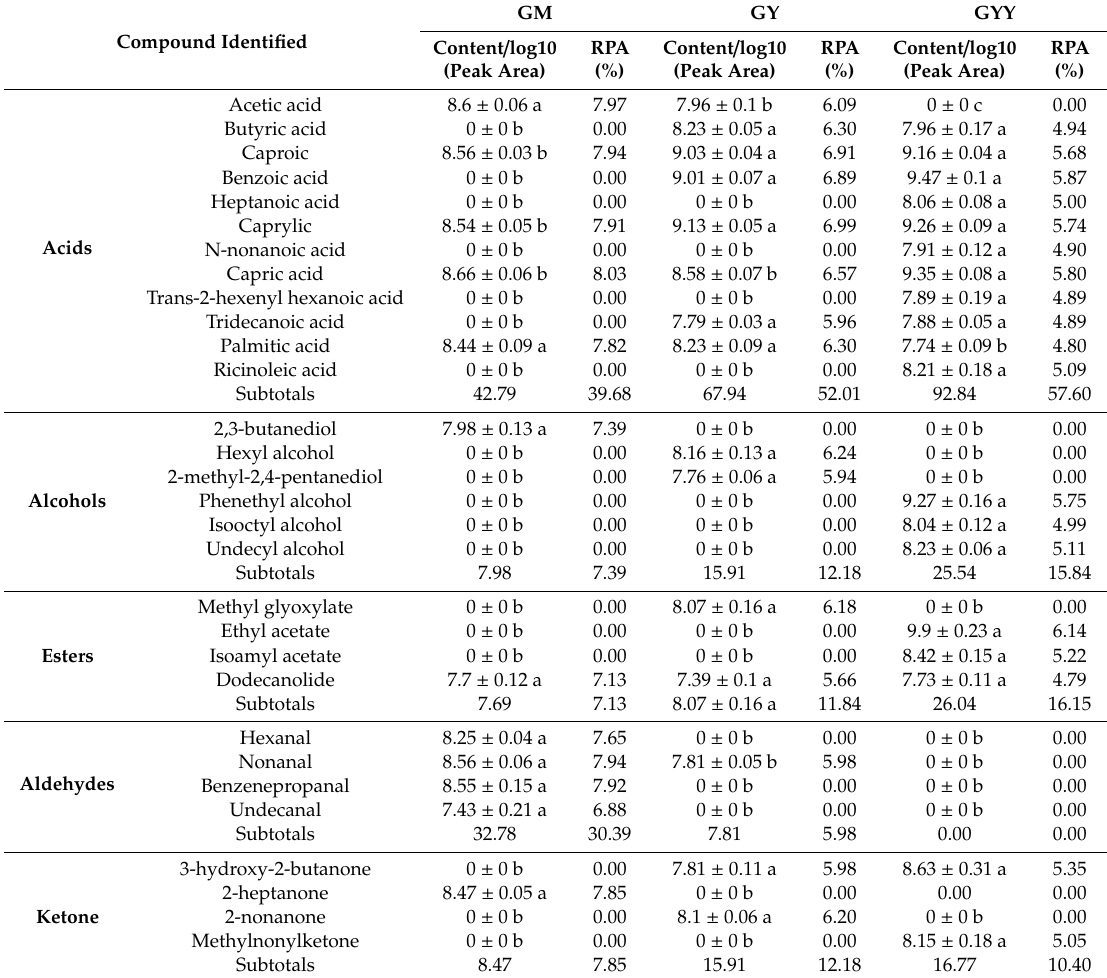
Table 2. Major volatile organic compounds detected and quantified in various groups of goat milk samples by